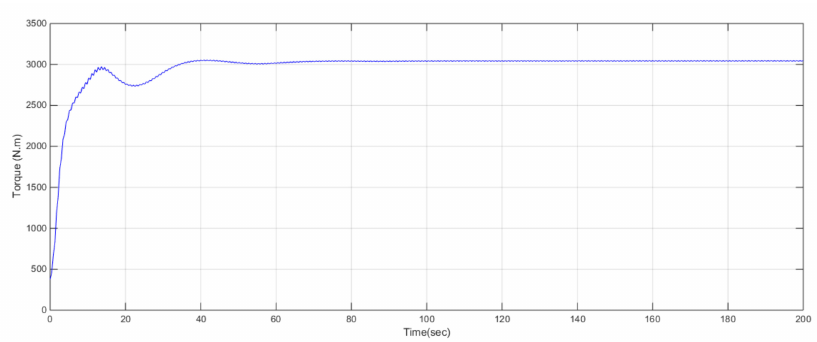
Figure 5. Generator torque control without